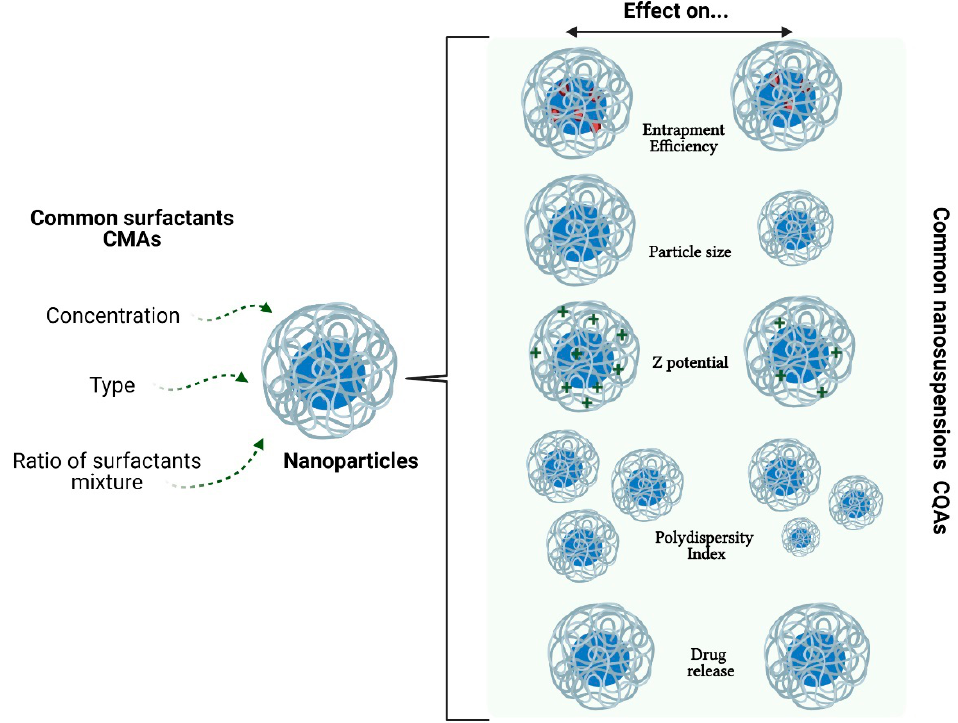
Figure 6. Common CQAs are affected by the most common CMAs of the surfactants.